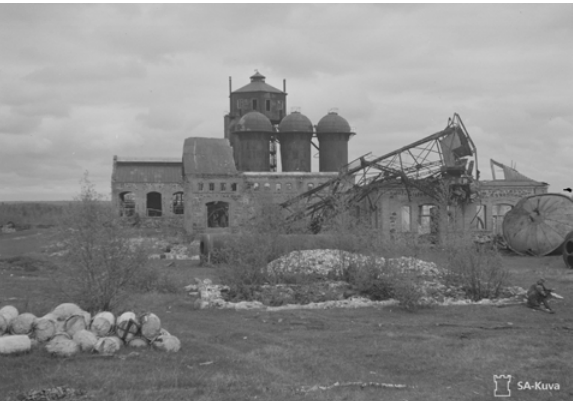
Figure 3. The Kolatselkä smelting plant in 1942 (photo: SA-kuva; CC BY 4.0